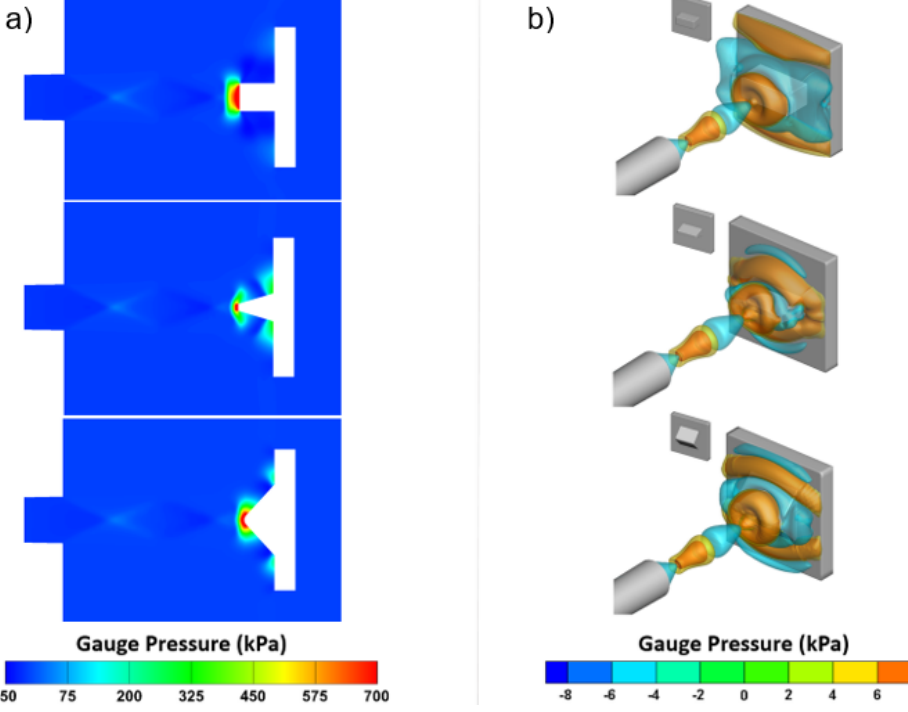
Figure 6. ( a ) Pressure contours and ( b ) iso-surfaces of pressure at the nozzle exit for the vertical wall (top), inclined wall (middle), and the smooth wall (bottom).